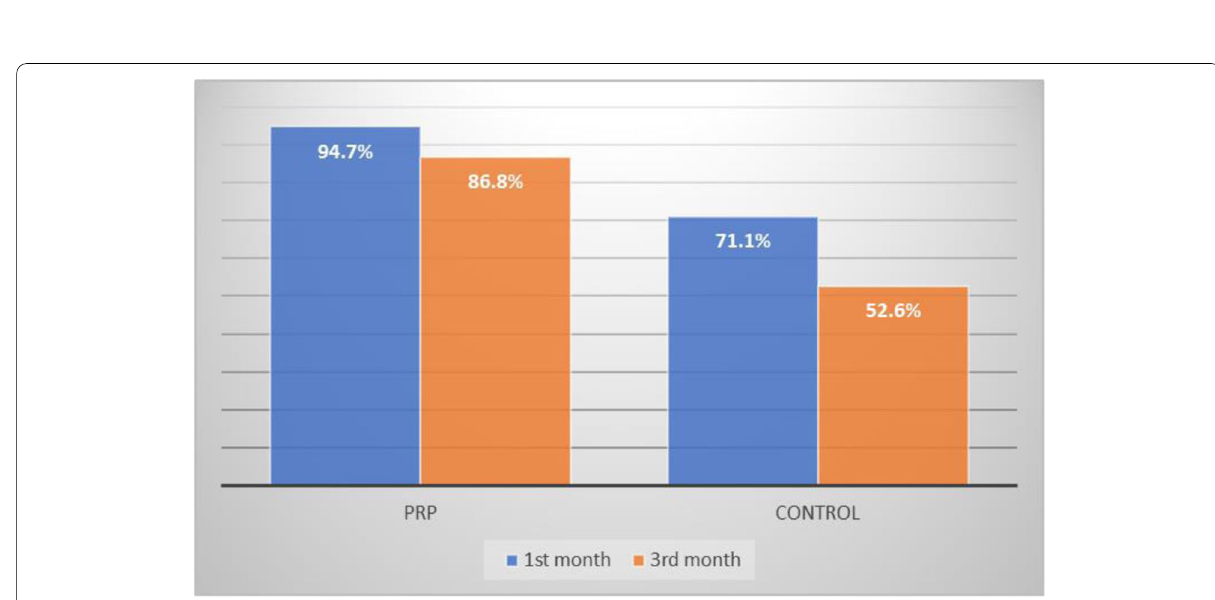
Fig. 10 Graphical representation of complete closure at 1st and 3rd months among both the